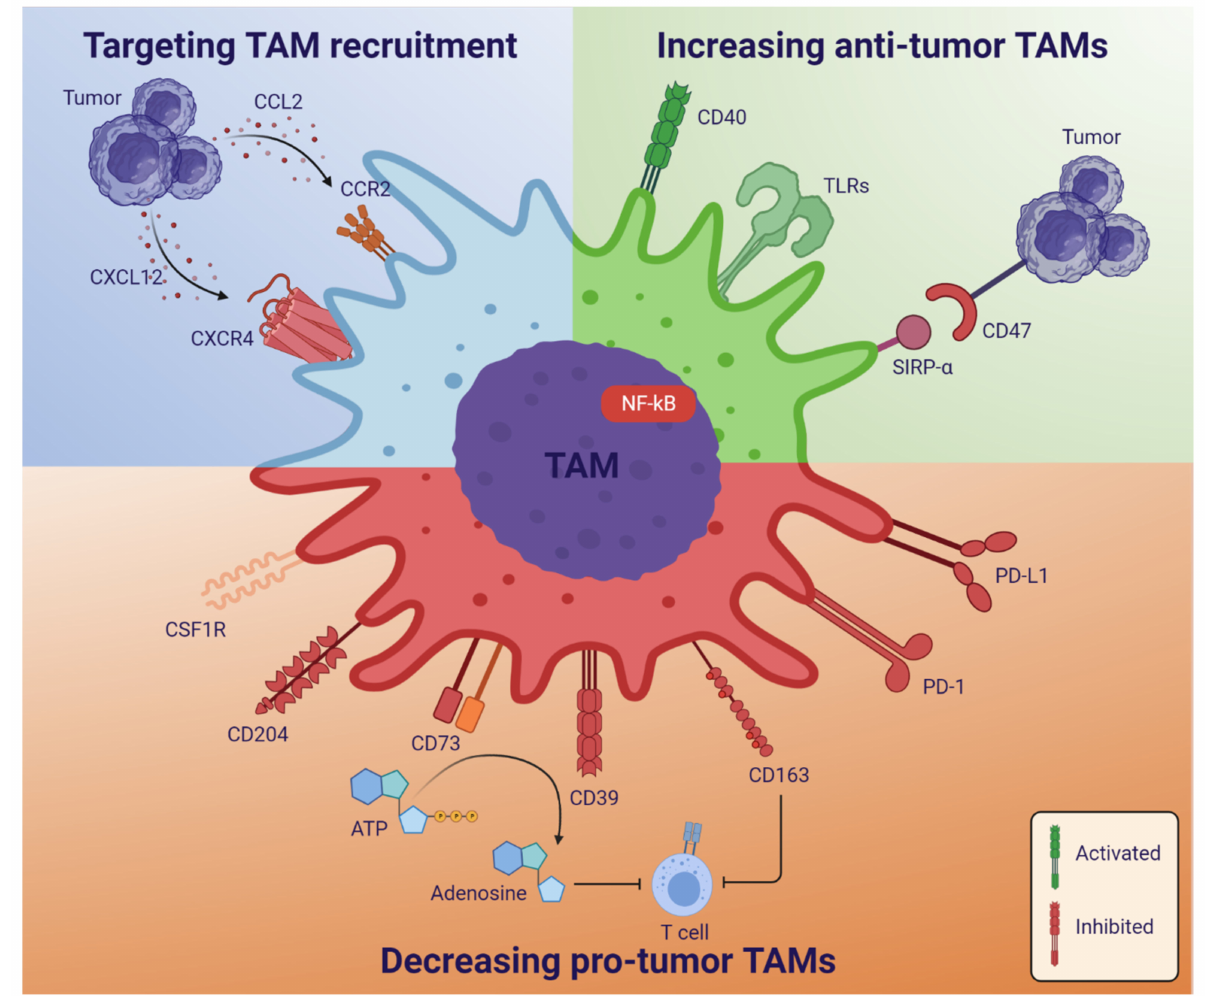
Figure 4. Therapeutic TAM-targeting in the treatment of glioblastoma. TAMs are potential therapeutic targets in the fight against glioblastoma, and these can be targeted in different ways. The recruitment of TAMs to the tumor can be targeted by inhibiting the chemokine signaling that attract TAMs to the TME (see the blue TAM part). A second strategy is to increase the numbers of anti-tumor M1-like TAMs to improve anti-tumor immune responses (see the green TAM part). A third strategy is to decrease the numbers of pro-tumor M2-like TAMs, which could in turn improve anti-tumor immune responses and possibly inhibit tumor progression (see the red TAM part). Targets illustrated in green should be activated by therapeutic treatments, while targets in red should be inhibited, as illustrated by the key in the bottom corner. Abbreviations: C-C motif chemokine receptor 2 (CCR2), C-X-C motif chemokine receptor 4 (CXCR4), CSF1 receptor (CSF1R), programmed death-1 (PD-1), signal regulatory protein- α (SIRP- α ), toll-like receptors (TLRs). Created with BioRender.com (accessed on 5 July